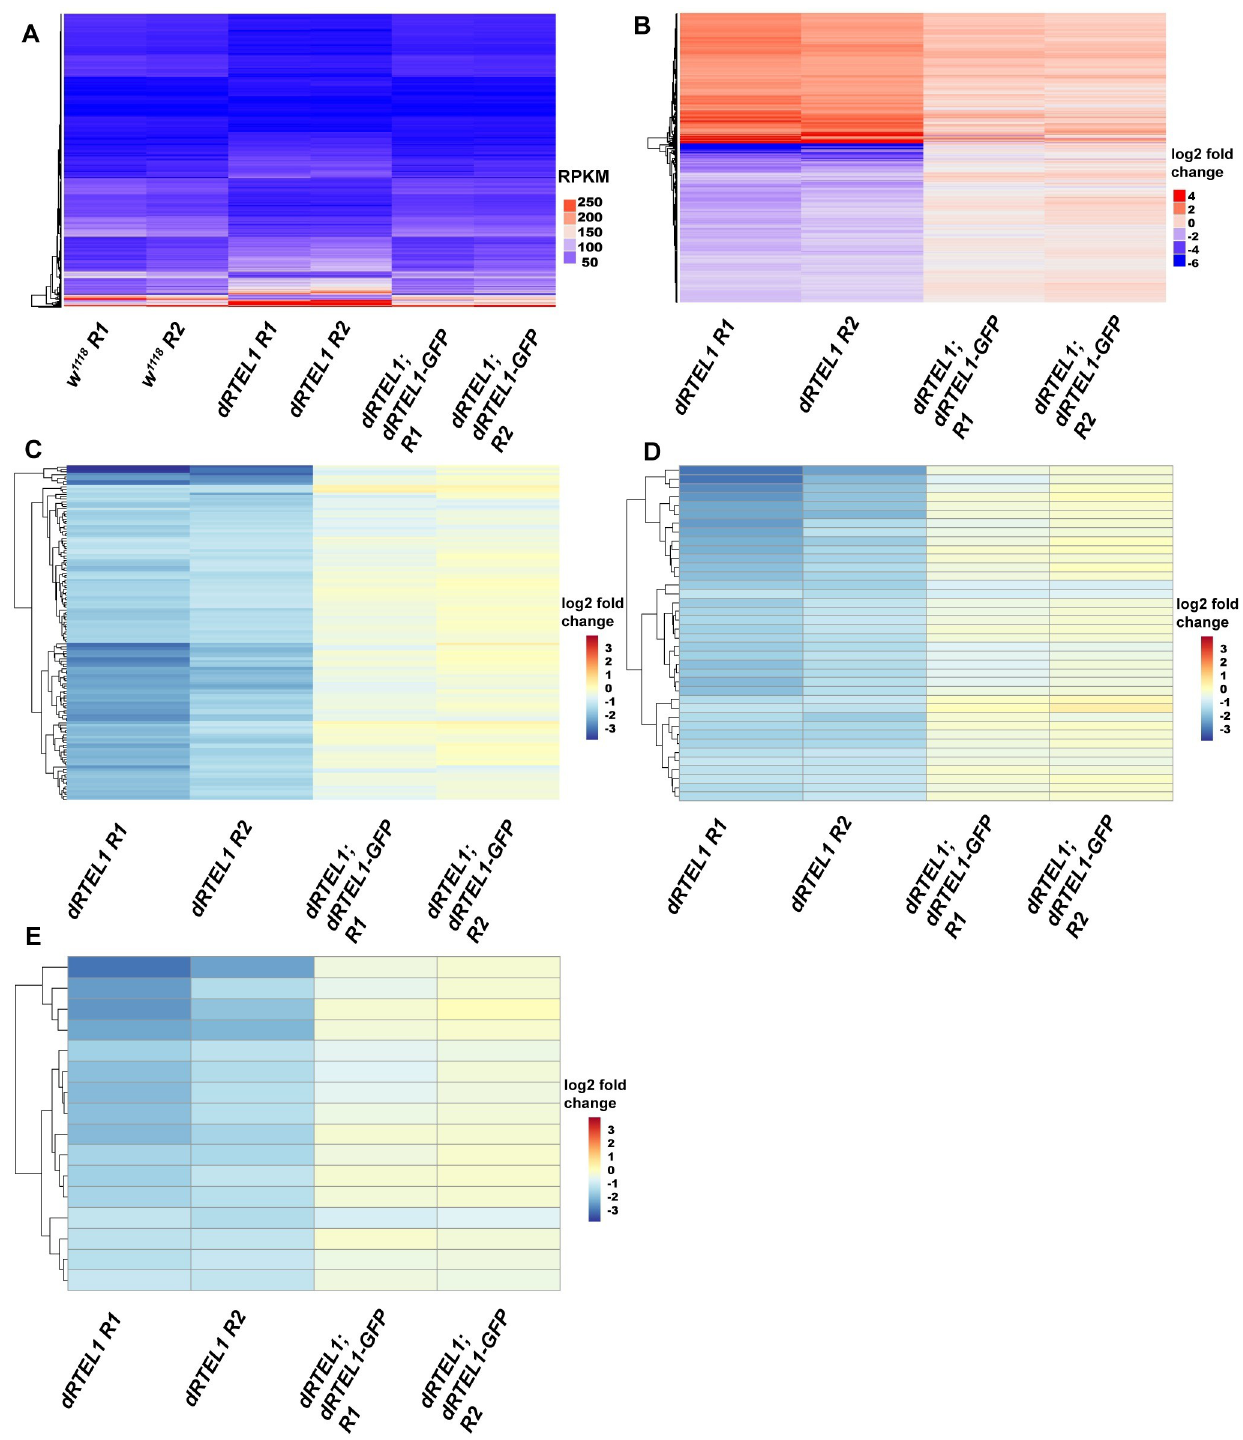
Fig 4. dRTEL1 affects expression of genes involved in GSC self-renewal and differentiation. (A and B) Summary of RNA-seq data. (A) The heatmap of expression level of 1,817 differentially expressed genes in w 1118 , dRTEL1 and dRTEL1; dRTEL1-GFP larval testes. (B) Heatmap of log2 fold change of gene expression profiles in dRTEL1 and dRTEL1; dRTEL1-GFP testis. For all samples, comparisons were made to w 1118 larval testes. (C) Heatmap of log2 fold change of gene expression profiles of 136 genes reported to be required for female germline development in dRTEL1 and dRTEL1; dRTEL1-GFP larval testes. (D) Heatmap of log2 fold change of gene expression profiles of 38 genes identified to cause the male GSC maintenance defect in dRTEL1 and